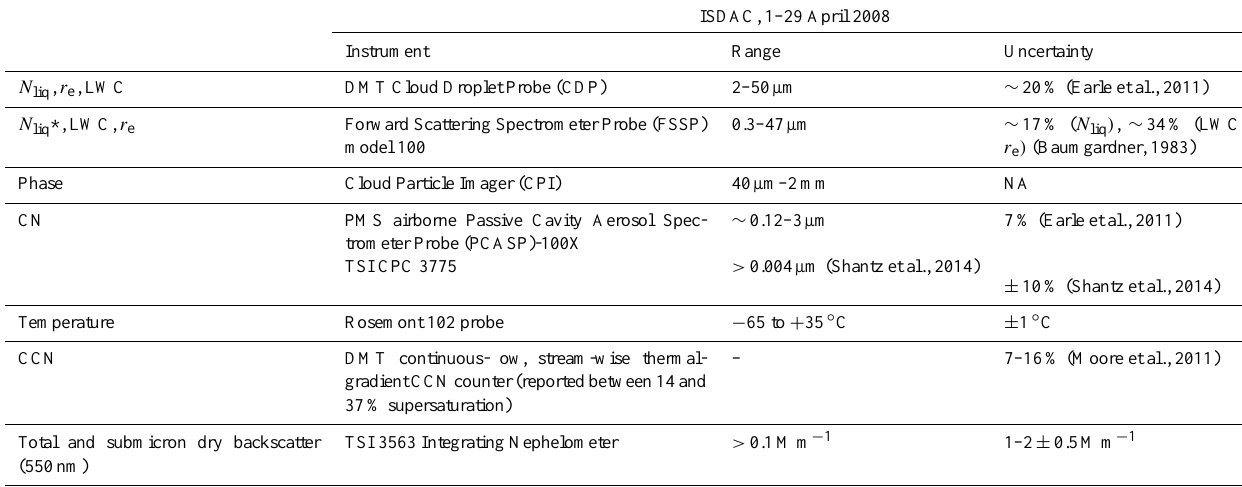
Table 2. Instrumentation used in this study from the ISDAC data set. Data were collected at 1s